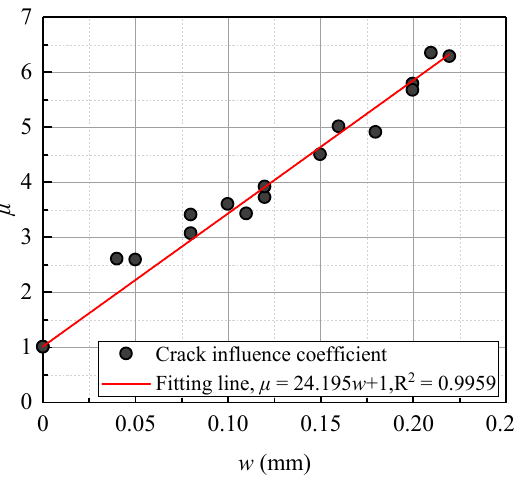
Figure 15. Fitting curve of crack width influence coefficient, μ , with crack width, w (mm).